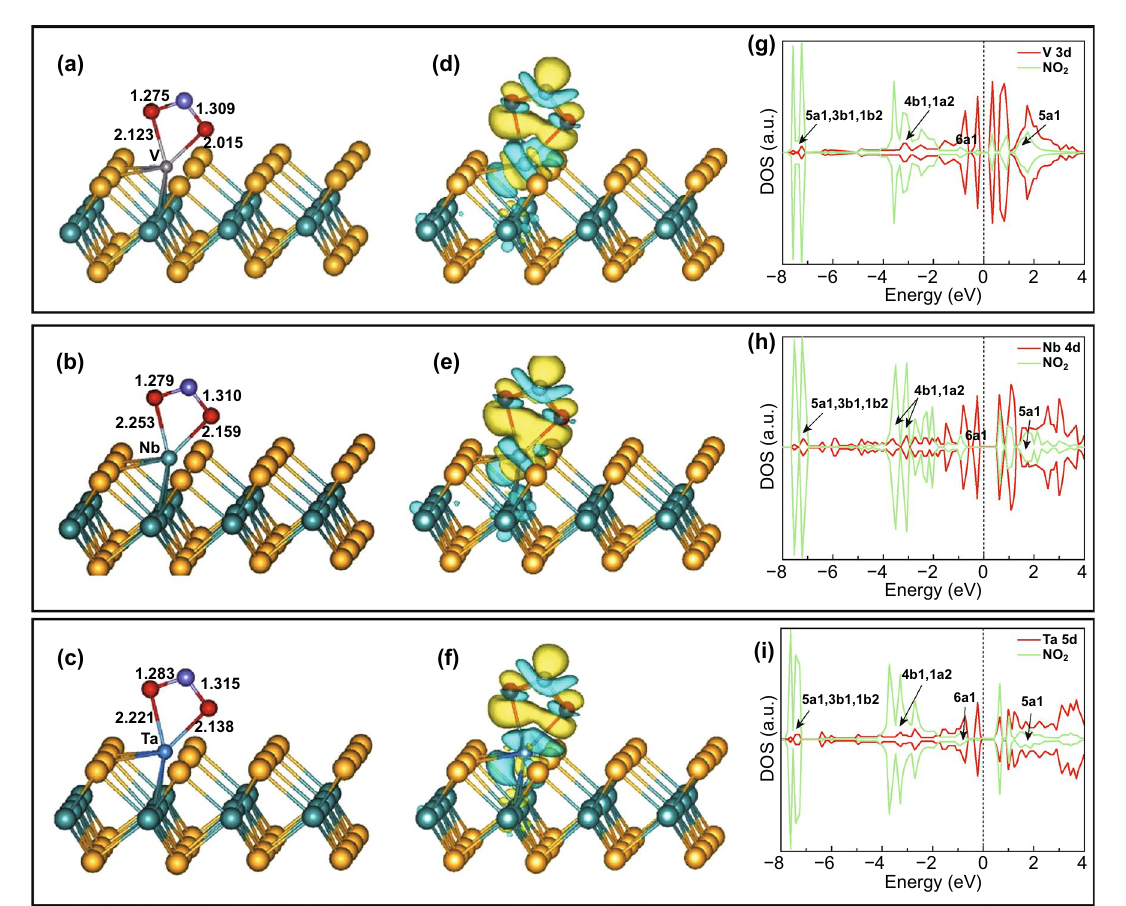
Fig. 9 a, d, g NO 2 molecule adsorbed on V metal: optimized geometry after NO 2 adsorption ( a ) , charge density difference ( d ), spin-polarized density of state with V 3d and NO 2 ( g ). b, e, h NO 2 molecule adsorbed on Nb metal: optimized geometry after NO 2 adsorption ( b ), charge den- sity difference ( e ), spin-polarized density of state with Nb 4d and NO 2 ( h ). c, f, i NO 2 molecule adsorbed on Ta metal: optimized geometry after NO 2 adsorption ( c ), charge density difference ( f ), spin-polarized density of state with Ta 5d and NO 2 ( i ). Reproduced with permission from Ref. [298]. Copyright (2017)